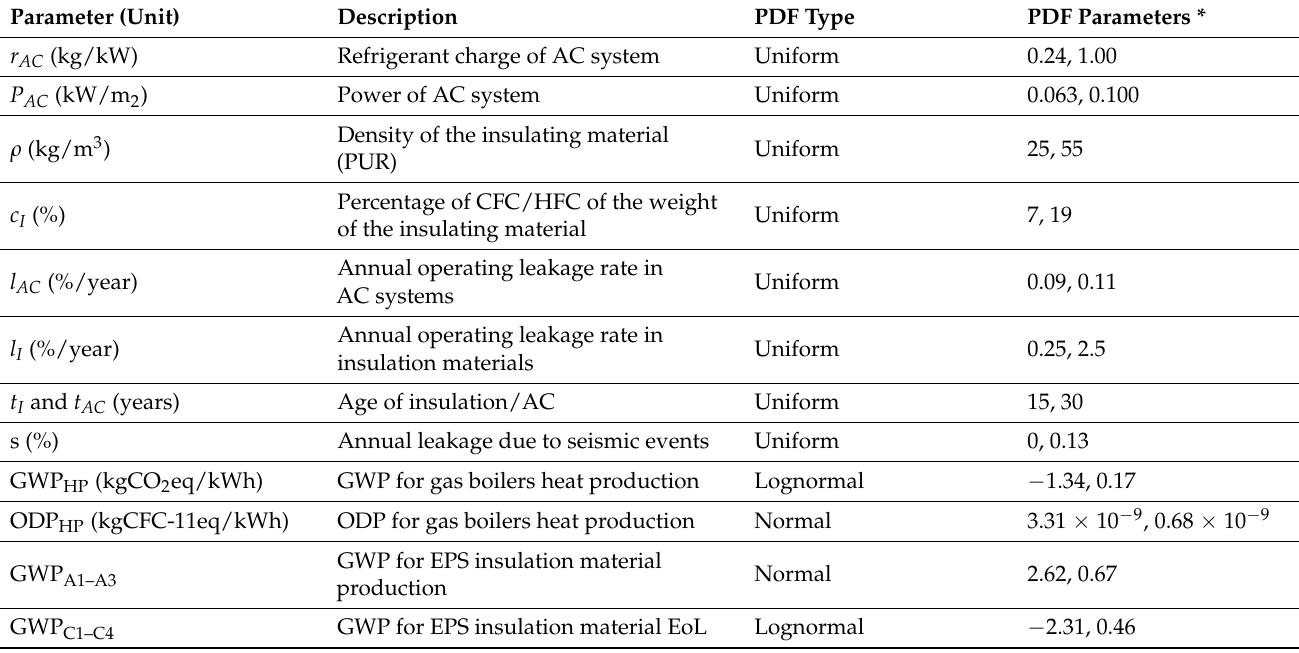
Table 1. Characteristics of the considered PDFs. * For uniform distribution, min and max; for normal distributions, µ and σ ; for lognormal distributions, µ log and σ log